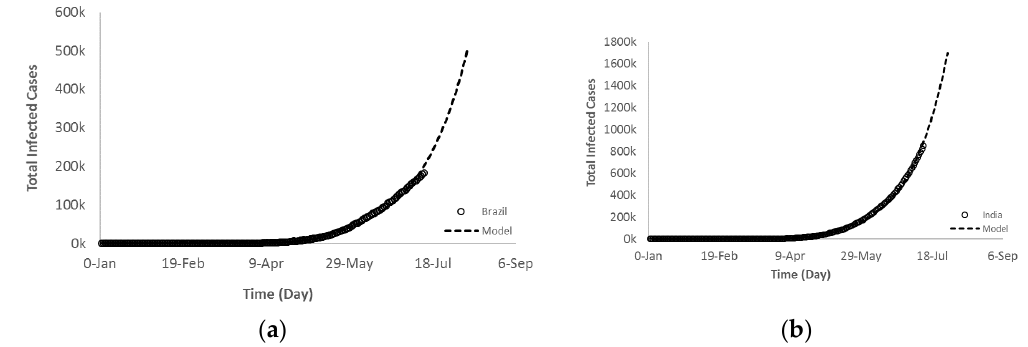
Figure 13. Exponential growth regression fit of the total COVID-19 infected cases of Group B countries ( a ) Brazil and ( b ) India.